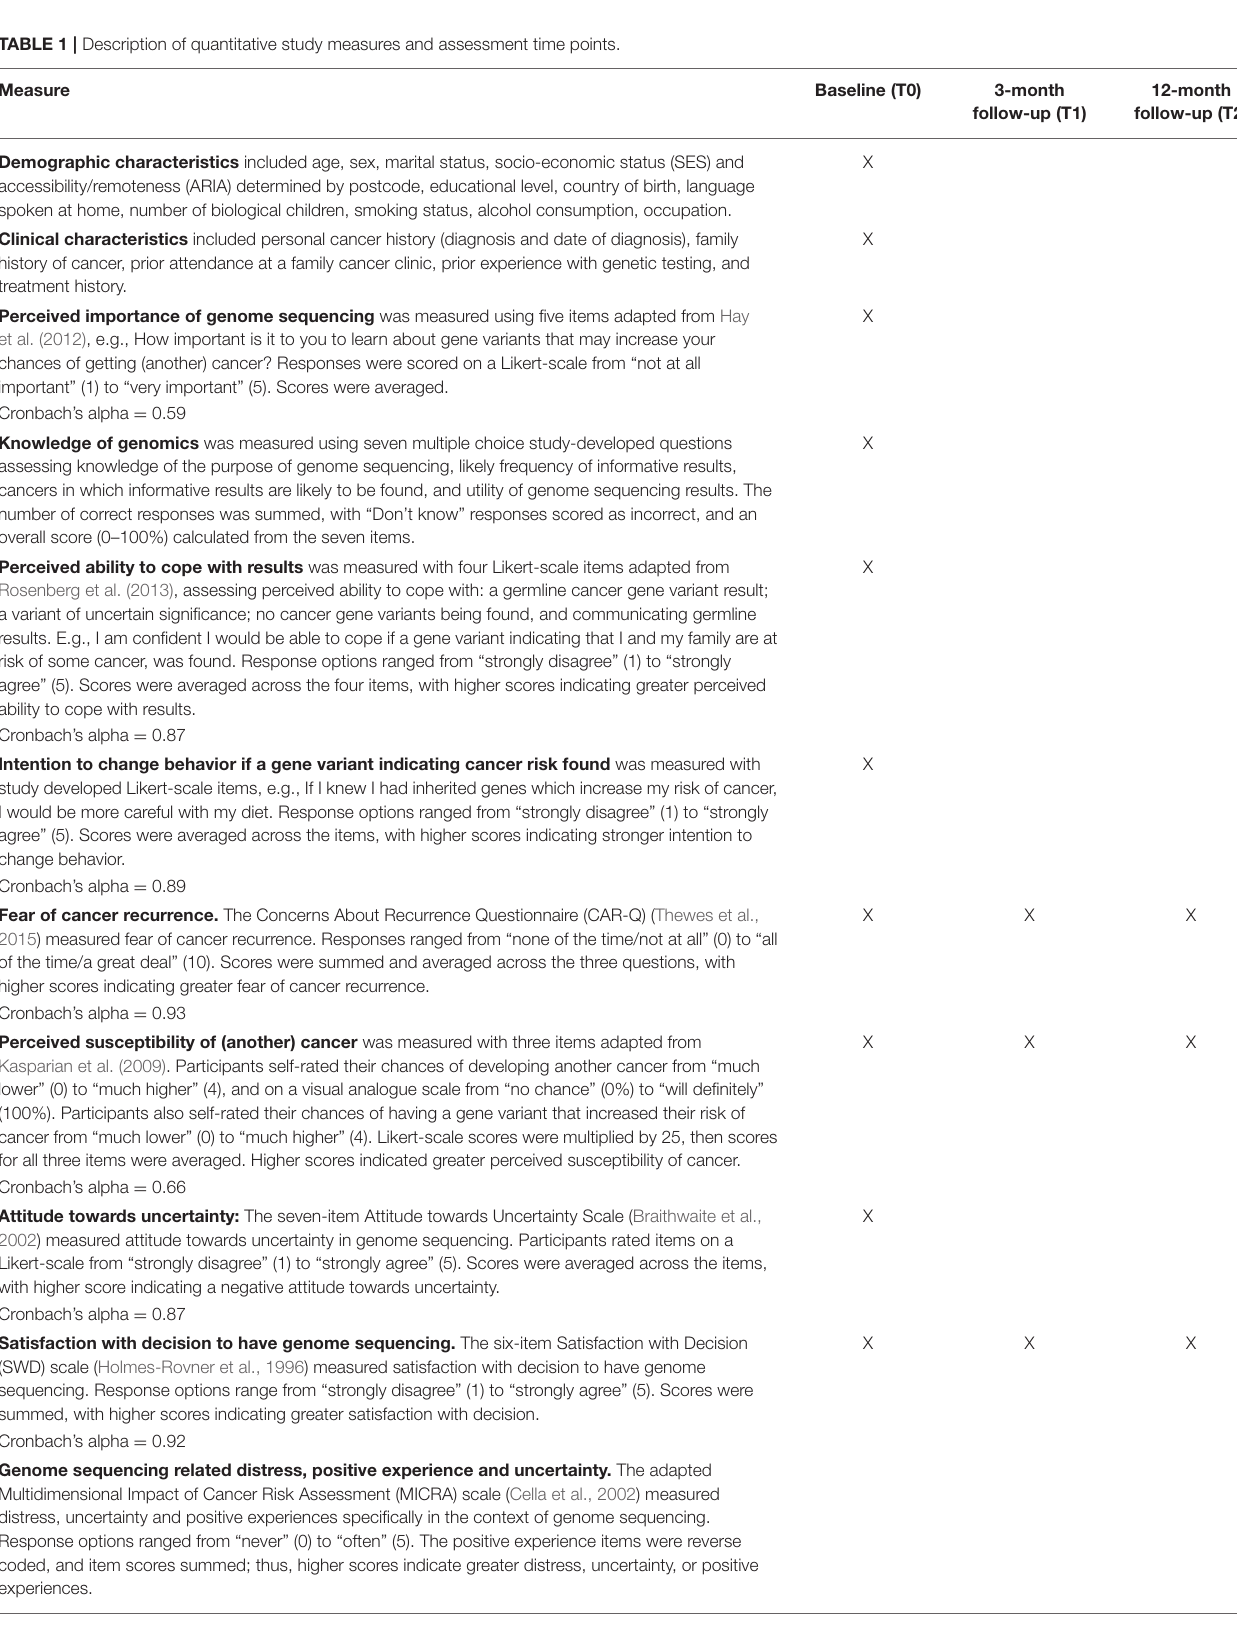
TABLE 1 | Description of quantitative study measures and assessment time points. Measure Baseline (T0) 3-month